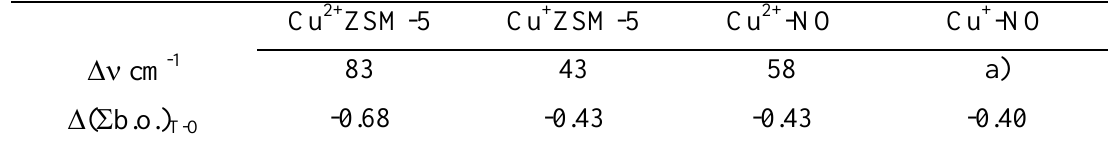
Table 2. The frequency shift from the position of unperturbed ring ( ∆ν =1020cm -1 - ν ) of IR band of T- O-T vibration for Cu 2+ and Cu + ions and their complexes with NO [11,14], and calculated changes in sums of T-O bond orders.